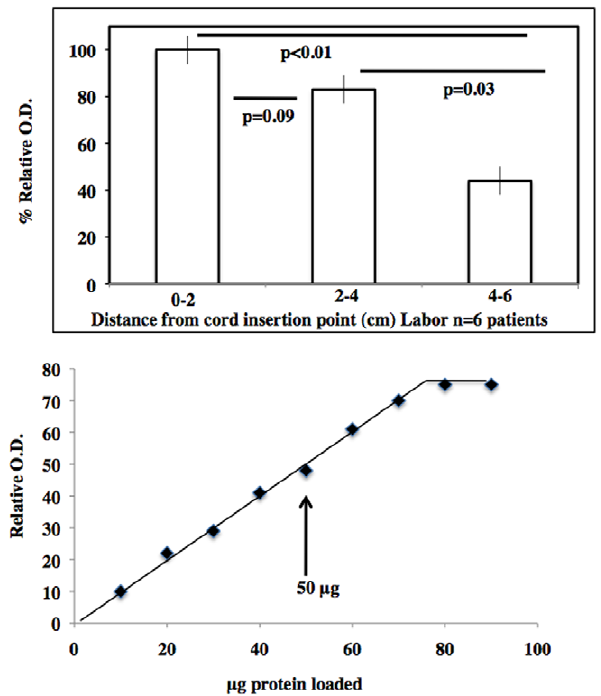
Figure 8. Shows HSP 70 expression in three different placenta zones for all patients in the labor group (n=6 patients) (upper panel). Quantification was performed using the BioRad documentation ECL imager system. The lower panel shows the relationship between protein loading and signal obtained.